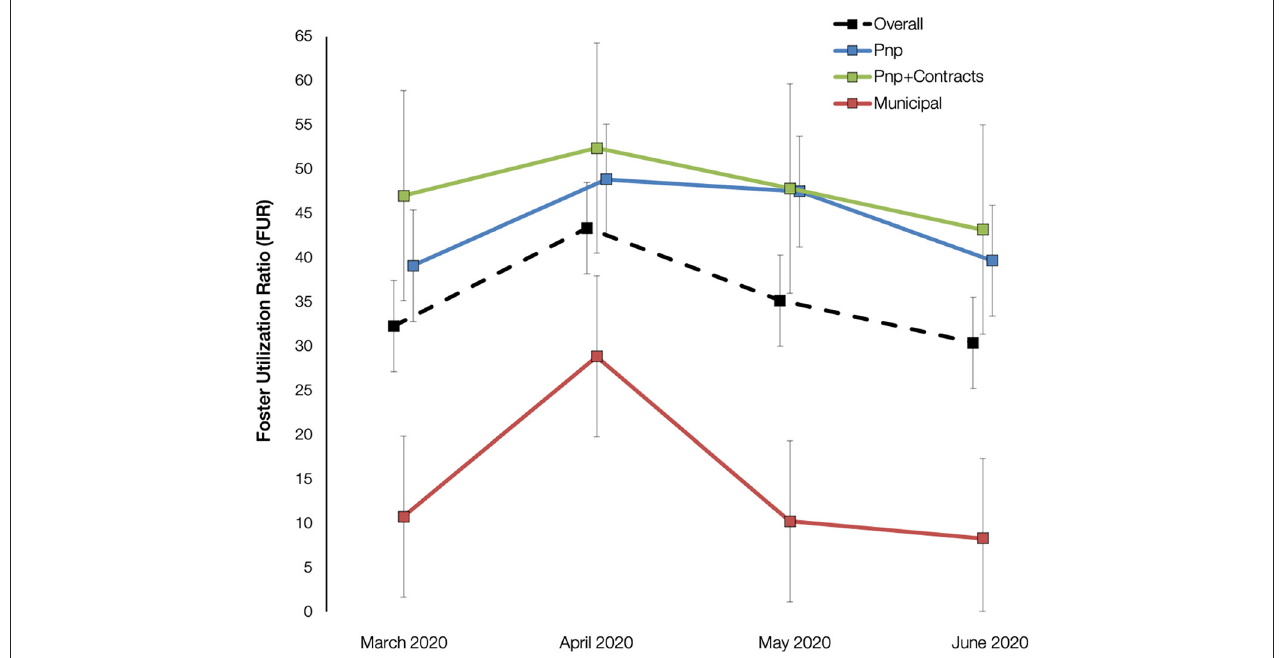
FIGURE 2 | Estimated marginal means and standard errors of foster utilization by organization type from March96June